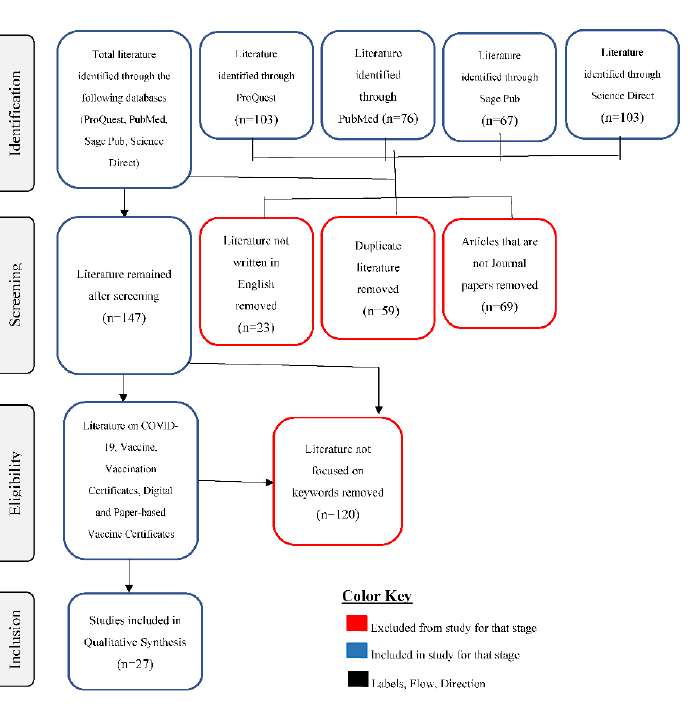
Figure 1. PRISMA flow for process of article inclusion and